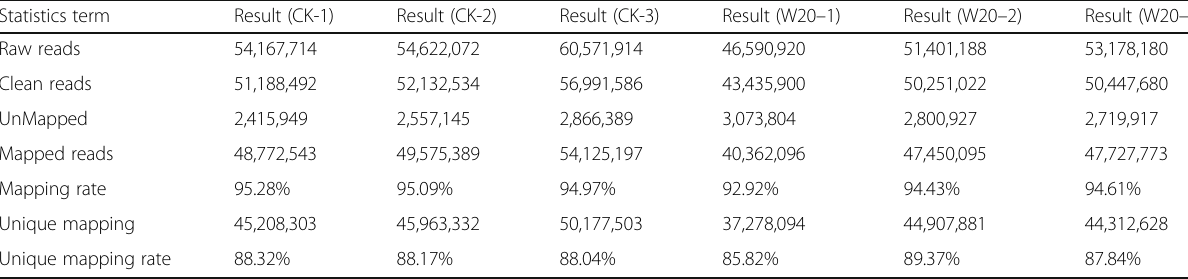
Table 1 Summary of mapping reads of the RNA-seq Statistics term